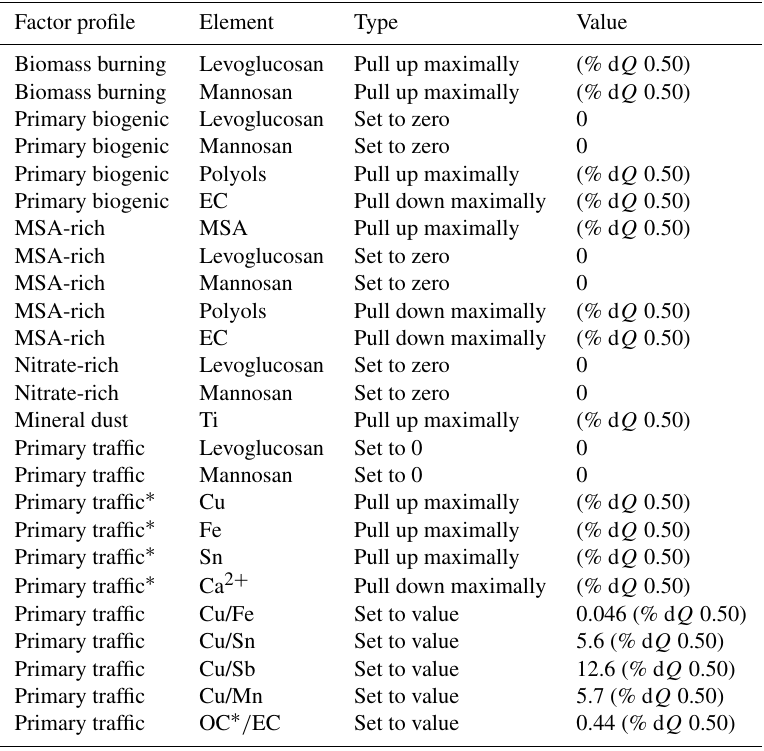
Table 1. Summary of the applied chemical constraints on source-specific tracers in the PMF factor